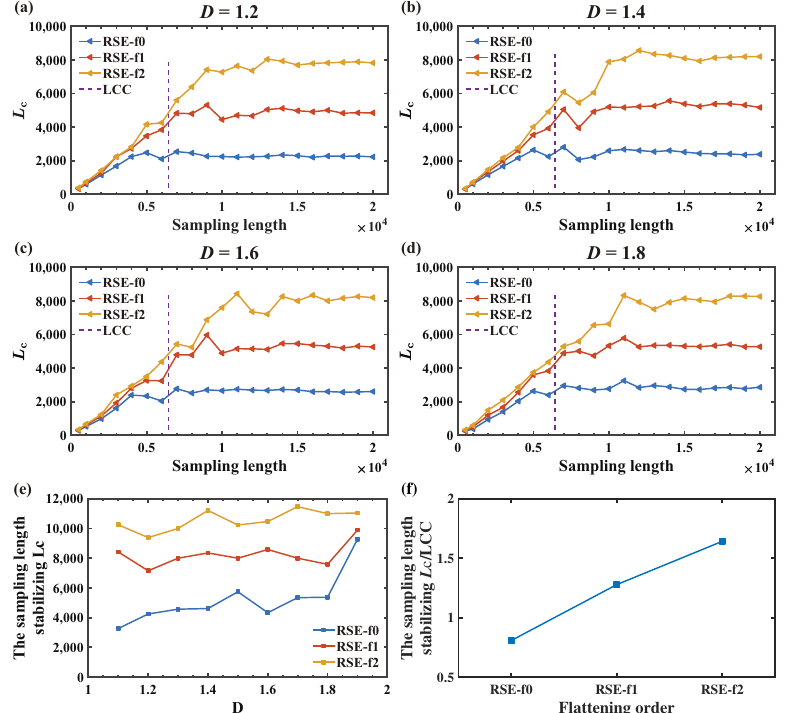
Figure 8. Typical relationship curves between the position of corner ( L c ) and sampling length under various flattening orders: ( a ) D = 1.2, ( b ) D = 1.4, ( c ) D = 1.6, ( d ) D = 1.8. ( e ) The sampling lengths that could stabilize L c when D ranged from 1.1 to 1.9. ( f ) The average folds relative to LCC of the sampling lengths, which could stabilize L c